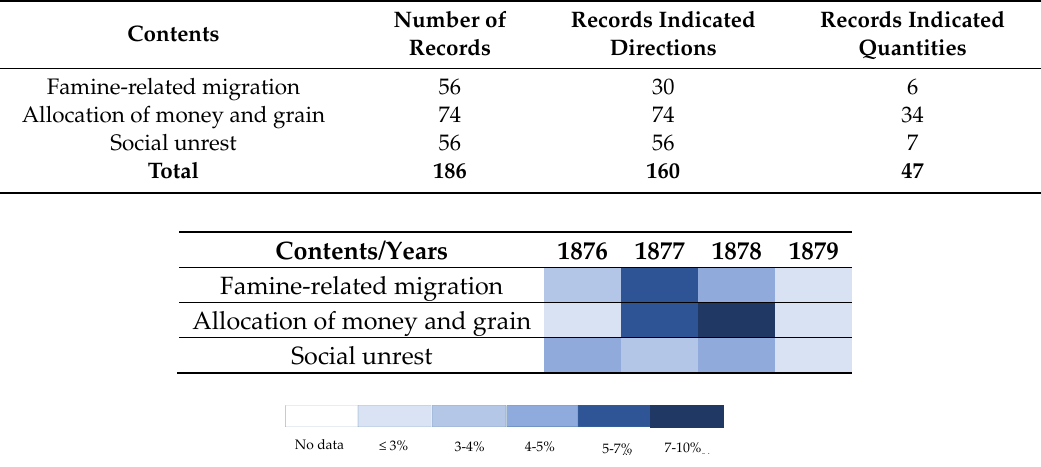
Figure 2. Percentage of days with records in each year from 1876 – 1879.